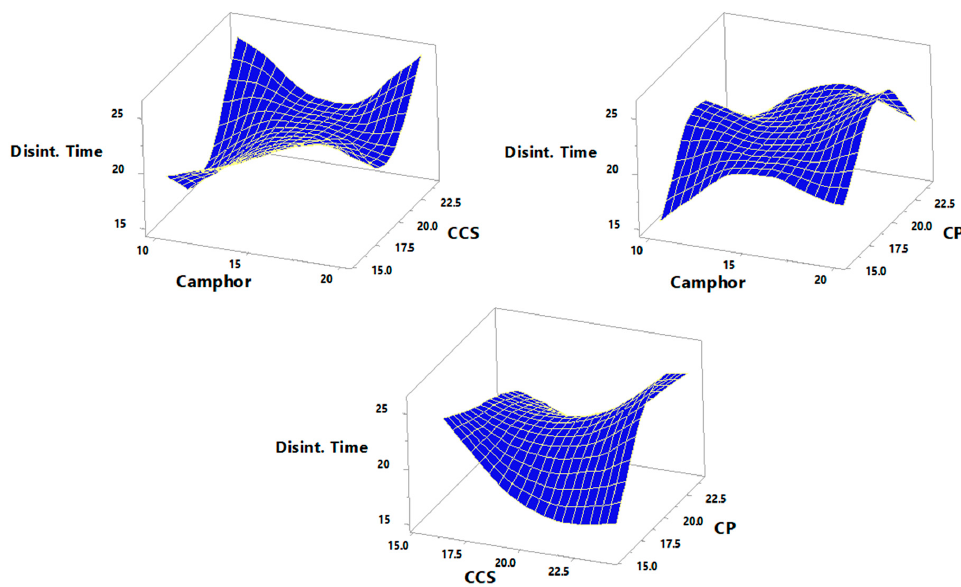
Figure 5. The three-dimensional contour plot for the effect of total amounts of super-disintegrates (X 1 ), (X 2 ) and percentage of sublimating agent (X 3 ) on the disintegration time (Y 2 ).